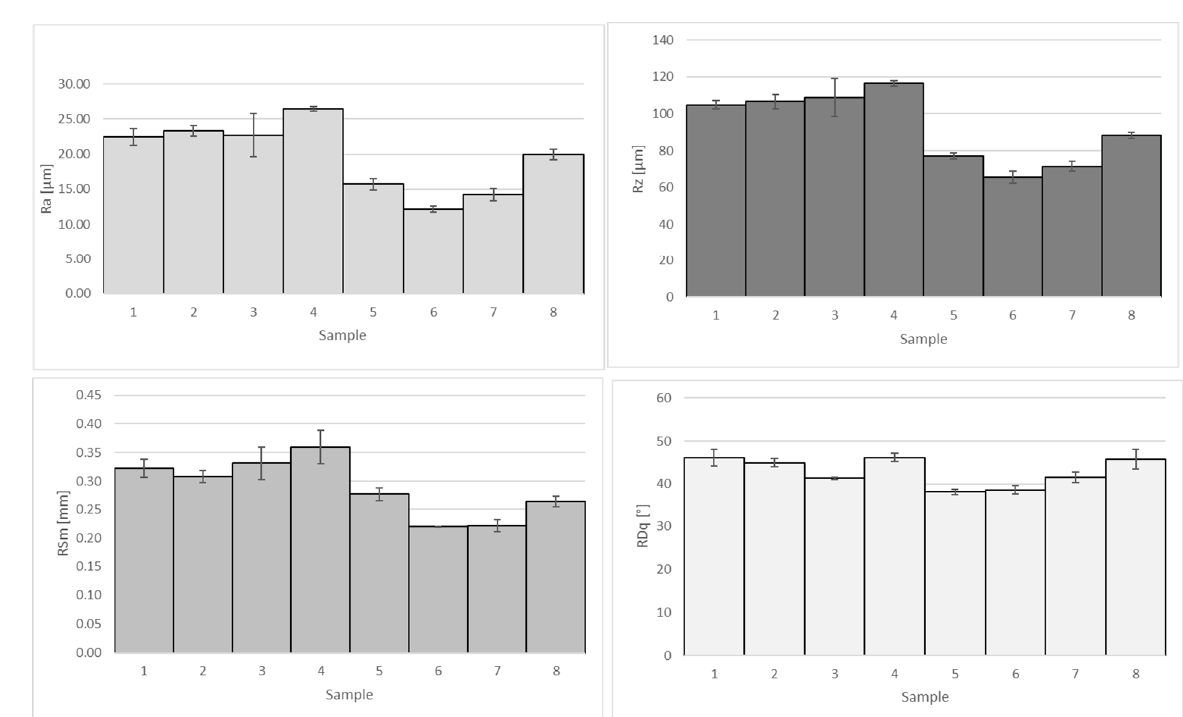
Figure 5. Roughens parameters of the composite coatings produced with different scenarios. Table 7. Anova results in terms of p -value and